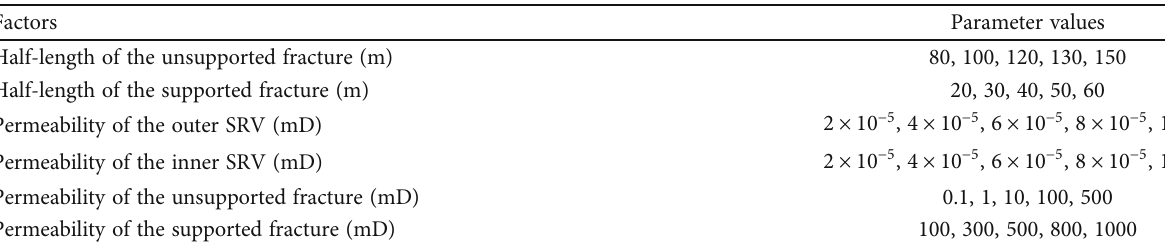
Table 3: Value of in fl uencing factors.